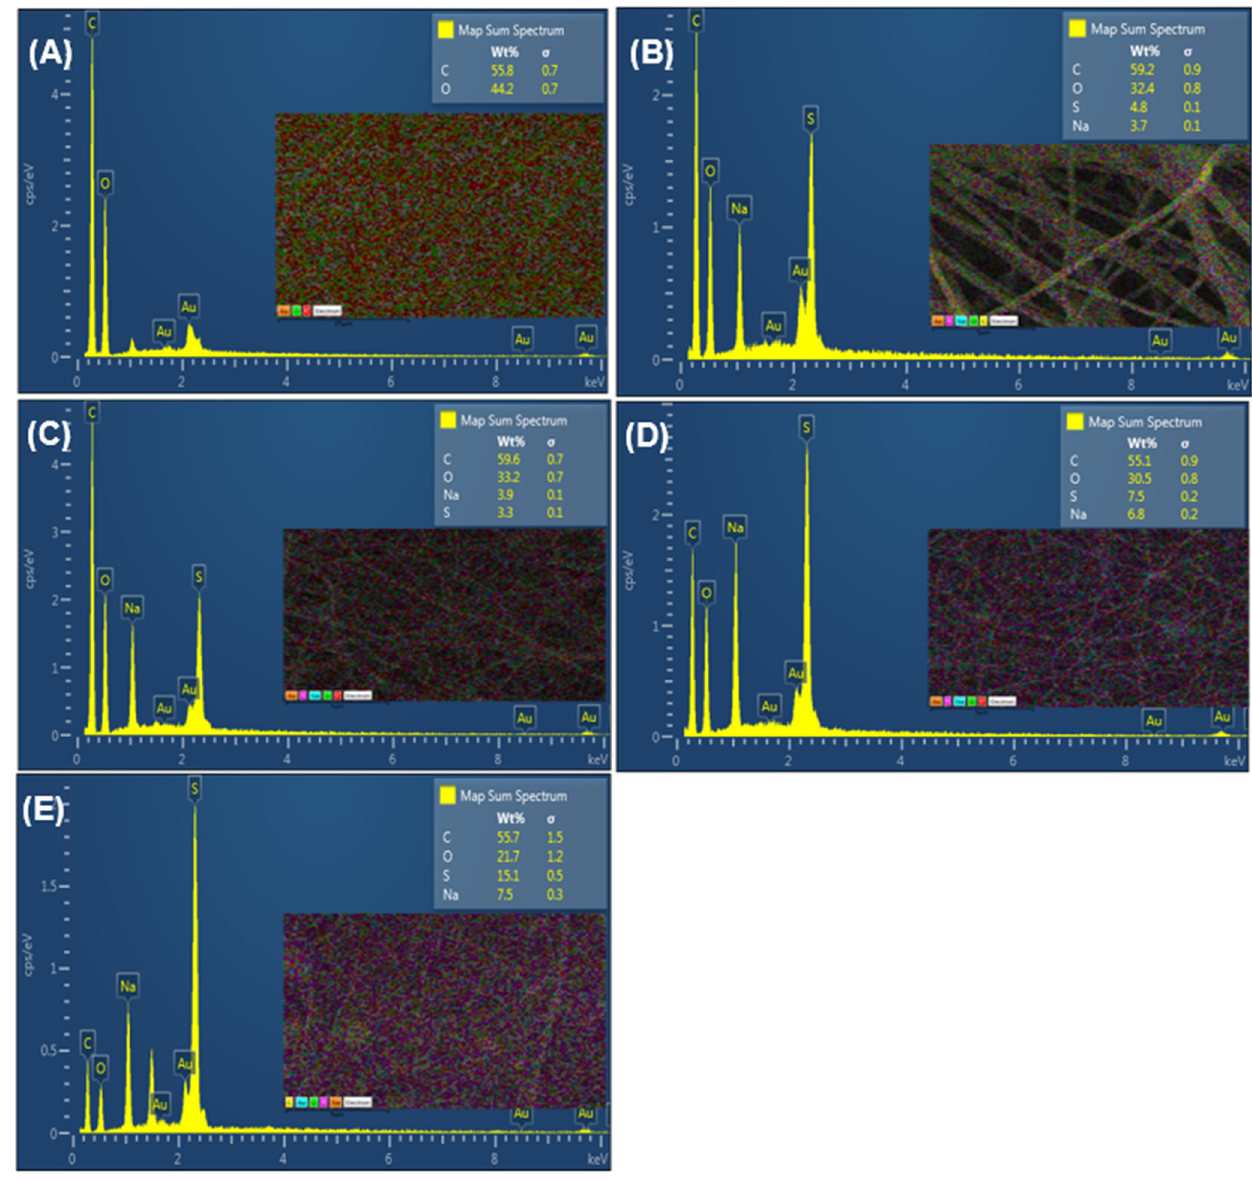
Figure 5. SEM-EDS EnPF meshes of homo- and PAA:PSS copolymers. ( A ) PAA, ( B ) P(AA- co -SS) (70:30), ( C ) P(AA- co -SS) (50:50), ( D ) P(AA- co -SS) (30:70), ( E ) PSSNa. The colored square represents the analyzed region on the sample of PAA. The colored square represents the analyzed region on the EPnF samples. Table 3. EDS measurements on EnPF meshes of PAA and PSSNa homopolymers and PAA:PSS co- polymers.